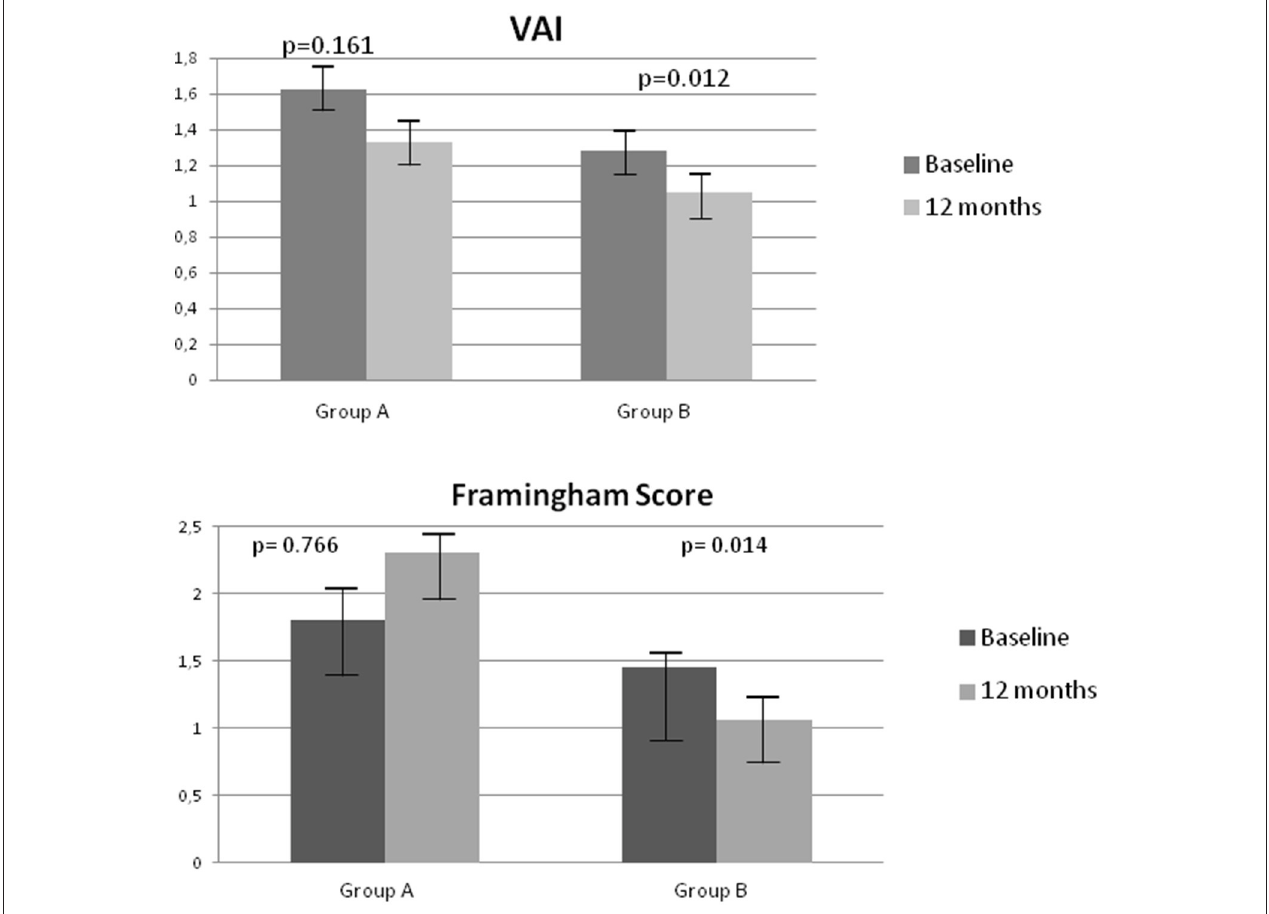
FIGURE 1 | Changes in Visceral Adiposity Index (VAI) and Framingham Risk Score (FRS) at baseline and after 12 months in groups A and